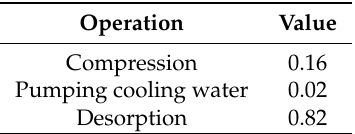
Table 12. Operation type contribution to optimal energy